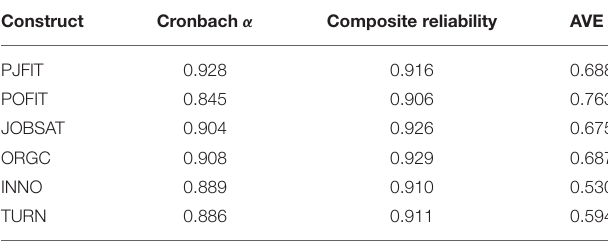
TABLE 4 | Standardized factor loadings and cross-loadings of the outer model. INNO PJFIT